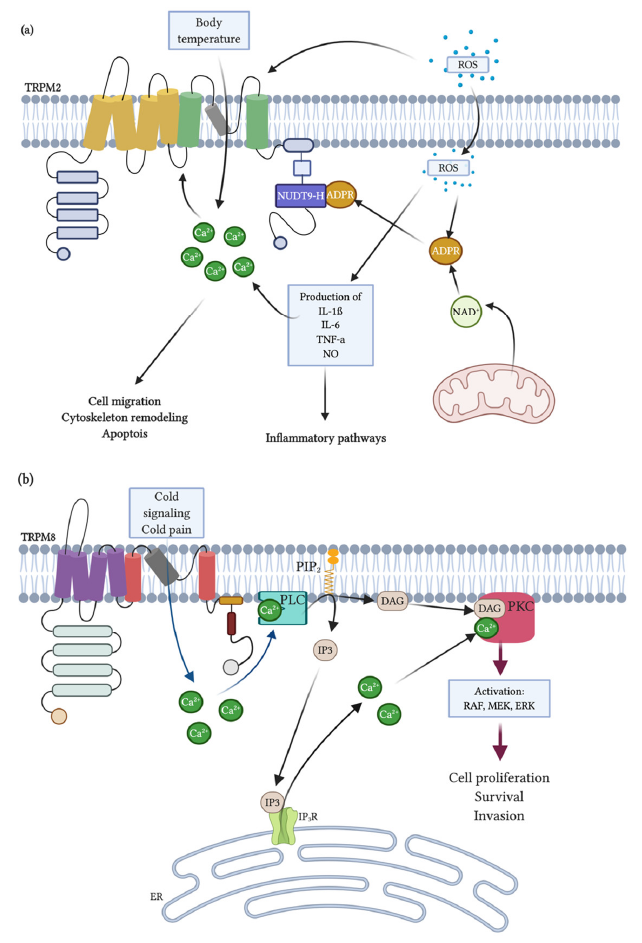
Figure 3. Signaling mechanisms for TRPM2 and TRPM8 activation. ( a ) NAD + and reactive oxygen species (ROS), including H 2 O 2 , accumulate during inflammation and tissue damage may trigger TRPM2. NAD+ may be converted to ADPR and cADPR. ROS can also cross the plasma membrane and mobilize ADPR from mitochondria and both ROS and cADPR can synergize with ADPR to activate TRPM2. Additionally, ADPR is generated from NAD+ via poly-ADPR during ROS-induced damage through the activation of PARP (poly(ADP-ribose) polymerase)-ADPR-dependent mechanisms in inflammatory cells. Free cytosolic ADPR can act on the NUDT9-H of TRPM2 channels, enabling Ca 2 + influx across the plasma membrane and / or release of intracellular Ca 2 + , raising the Ca 2 + concentration in the cytosol. On the other hand, ROS induces cytokine production (pro-inflammatory response), which may alter intracellular calcium levels. A Ca 2 + increase will activate di ff erent physiological processes including gene expression through Ca 2 + -dependent signaling pathways such as apoptosis, cell migration and cytoskeleton remodeling. Moreover, TRPM2 may detect increased temperatures to prevent overheating, limiting the fever response. ( b ) Cold temperature, menthol or icilin can stimulate the activity of the TRPM8 ion channels. Upon activation, the TRPM8 channel changes conformation and permits extracellular Ca 2 + to flow through it across membranes. This results in the activation of Ca 2 + -sensitive PLC and the hydrolysis of PIP 2 , which produces inositol 1,4,5-triphosphate (IP 3 ) that causes the release of Ca 2 + from the intracellular stores and generates diacylglycerol (DAG). The elevated Ca 2 + level or DAG can activate protein kinase C (PKC), which, in turn, activates RAF in the ERK pathway. Therefore, transcriptional activation of genes stimulates cellular proliferation, survival and invasion, which contribute to cancer growth and metastasis. Created with